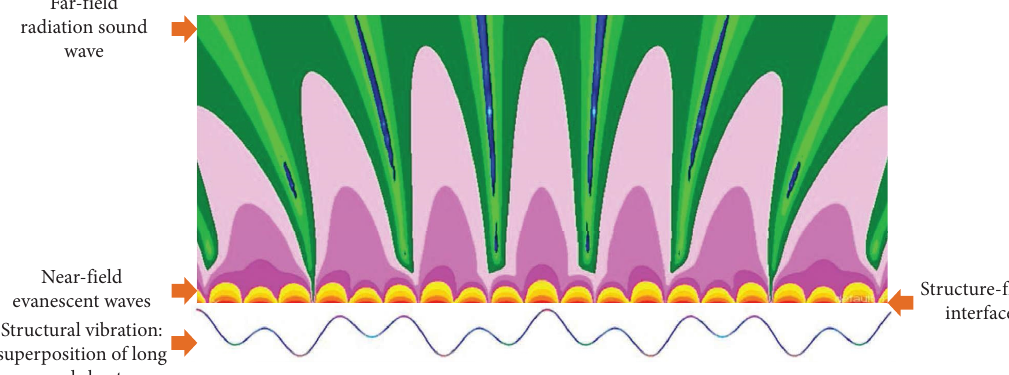
Figure 1: Te acoustic radiation model of large, complicated structure vibrating at low